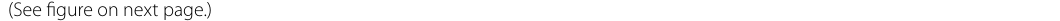
Fig. 2 Top panel: The believed distribution of latent strength values for targets (darker gray) and lures (lighter gray) up to the point in which the target (solid circle) or a lure (solid square) are encountered. Note that both latent strengths are below the response criterion (solid black line), which is set at the point of equal likelihood (i.e., where both distributions intersect). Middle panel: The updated believed distributions of latent strength values if the lure was encountered and rejected. Bottom panel: The updated believed distributions of latent strength values if the target was encountered and rejected instead. In both the middle and bottom panels, the prior response criterion (dotted red line) is given for